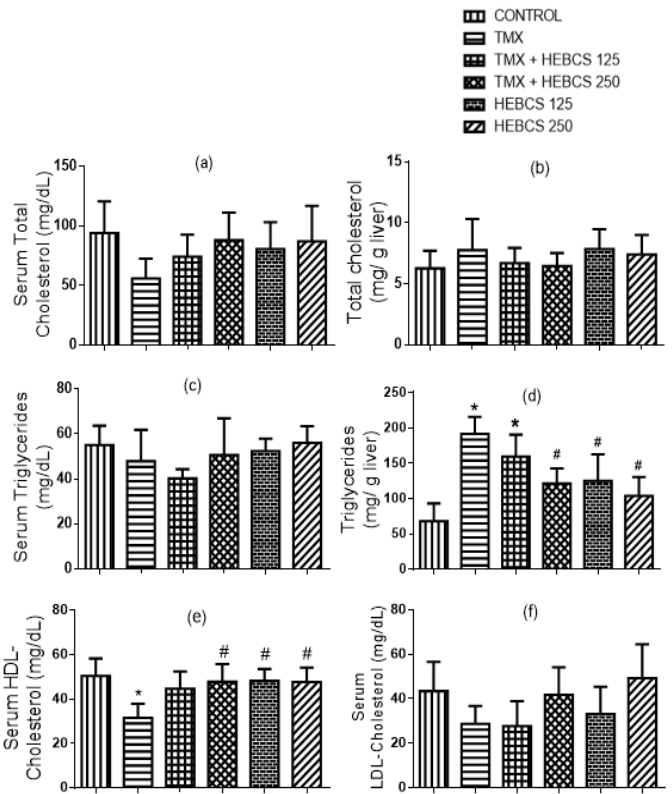
Figure 6. Ameliorative effect of HEBCS against TMX–induced alteration in serum and hepatic lipids concentrations ( a ) serum total cholesterol; ( b ) hepatic total cholesterol; ( c ) serum triglycerides; ( d ) hep- atic triglycerides; ( e ) serum high density lipoprotein-cholesterol (HDL-cholesterol); ( f ) serum low density lipoprotein-cholesterol (LDL-cholesterol). Data are presented as mean ± SD ( n = 6). * p < 0.05 Control versus other groups; # p < 0.05 TMX versus HEBCS groups. TMX: Tamoxifen; HEBCS 125 and 250: Hydroethanolic Extract of Buchholzia coriacea Seeds, 125 and 250 mg/kg body